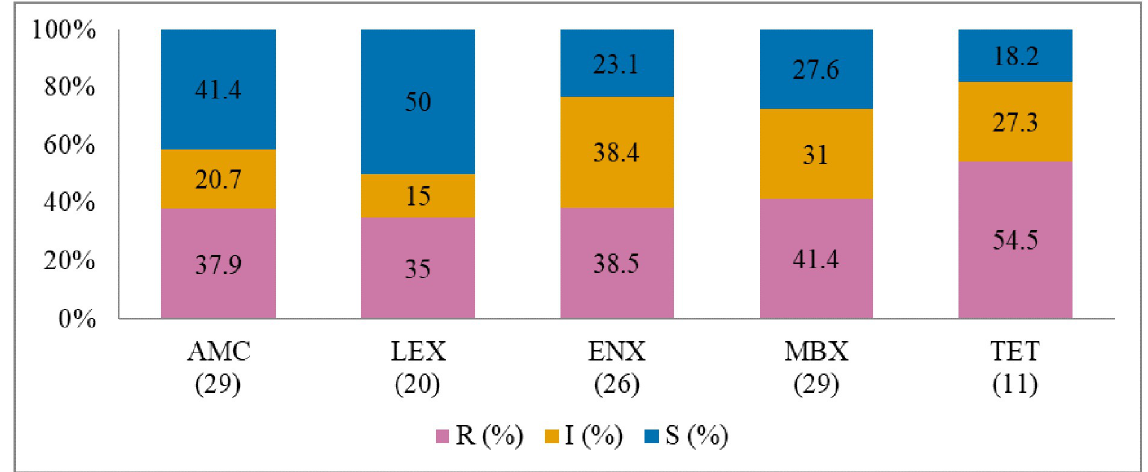
Fig 10. Antibiotic susceptibility pattern from Staphylococcus pseudintermedius isolates from diseased dogs (January 2015-December 2017). R–resistance; I-intermediate; S–susceptible; AMC–amoxicillin/clavulanic acid; LEX–cephalexin; ENX–enrofloxacin; MBX– marbofloxacin; TET–tetracycline. Numbers inside brackets ‘()’ indicate the total number of tested isolates for each